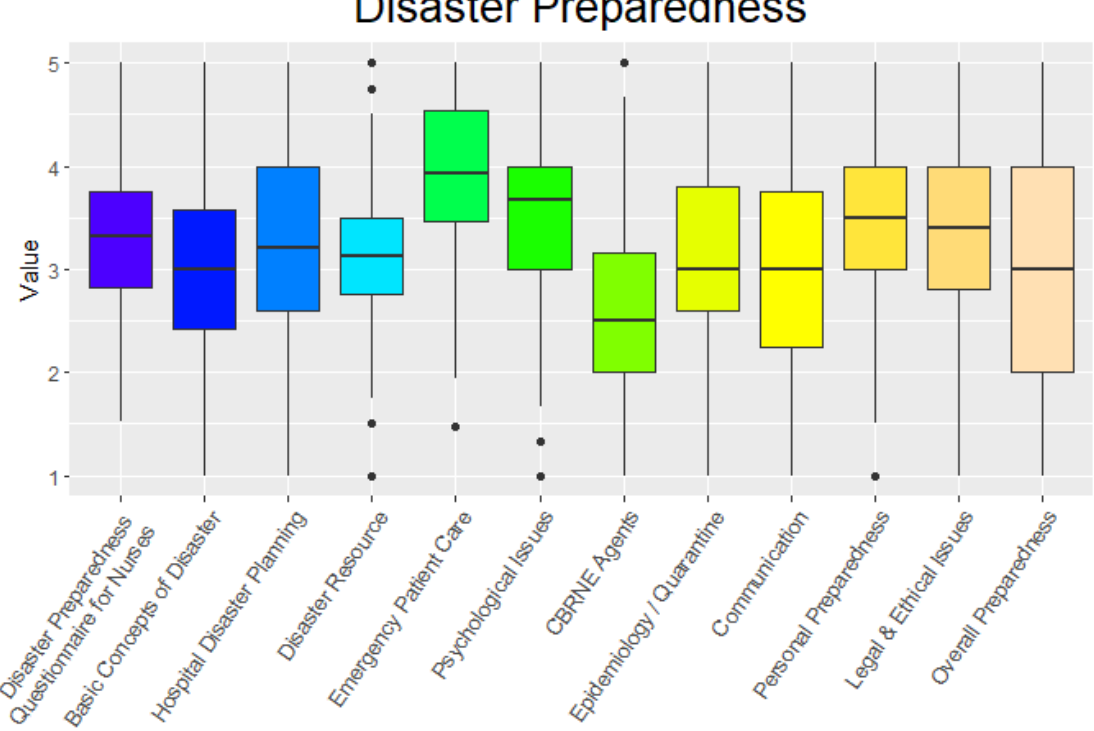
Figure 1. Results of the Disaster Preparedness Questionnaire for Nurses. CBRNE: Chemical, Biological, Radiological, Nuclear, and high yield Explosives.